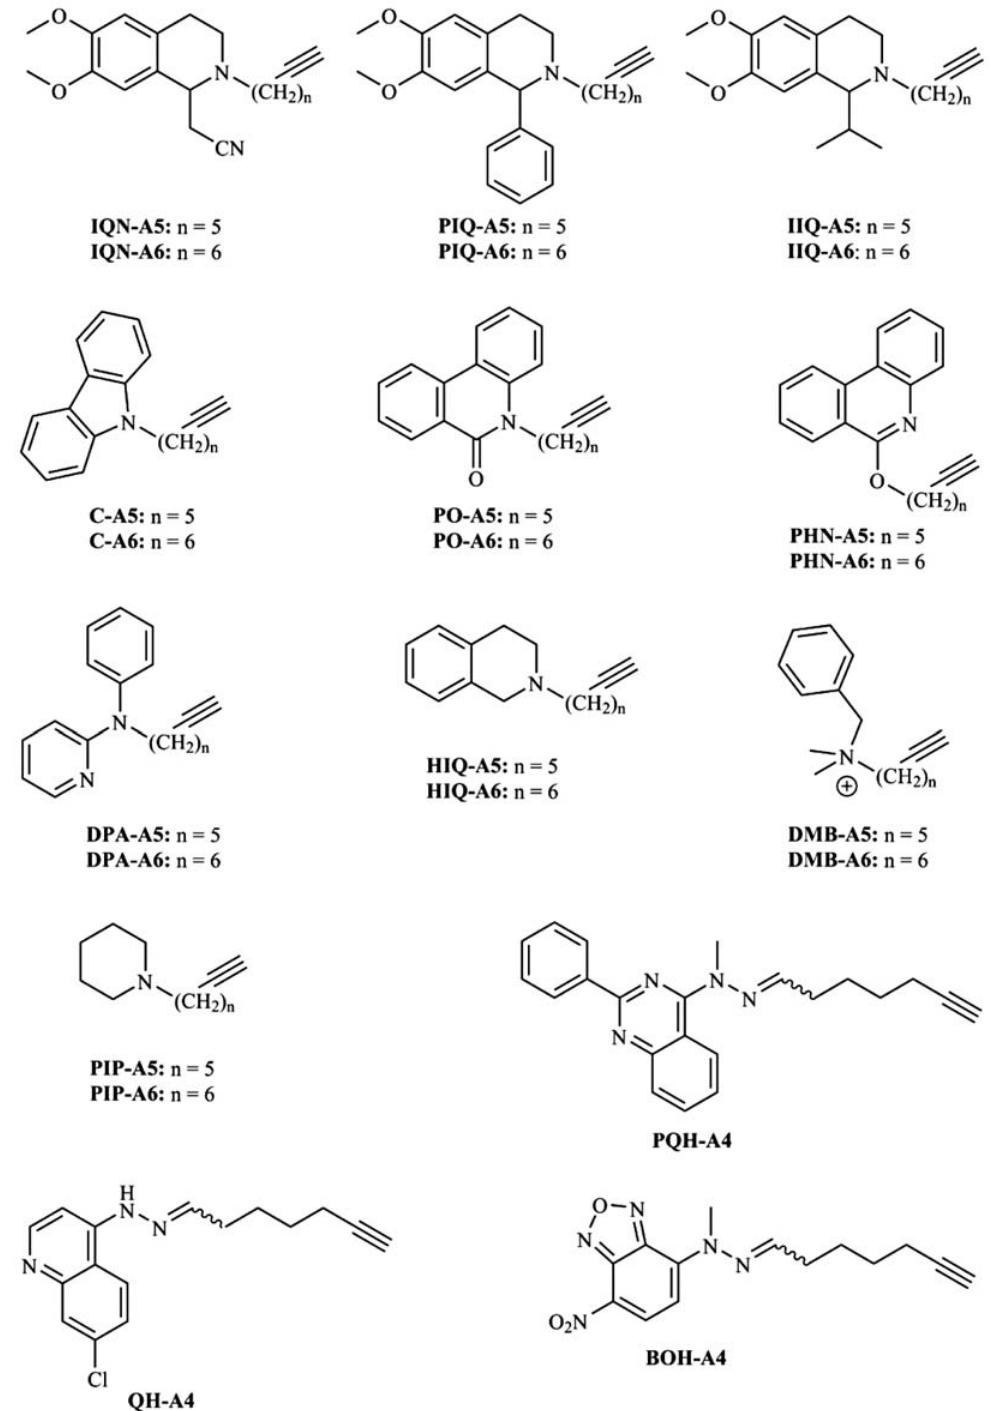
Figure 13. A library of acetylene building blocks for in situ click chemistry screening of AChE.